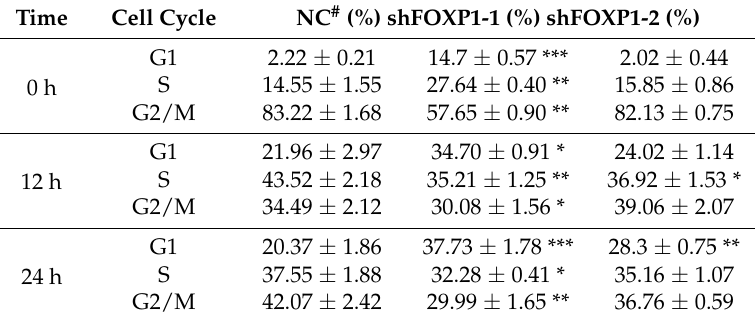
Table 1. Cell cycle distribution of Huh7 cells after transfecting lenti-control and